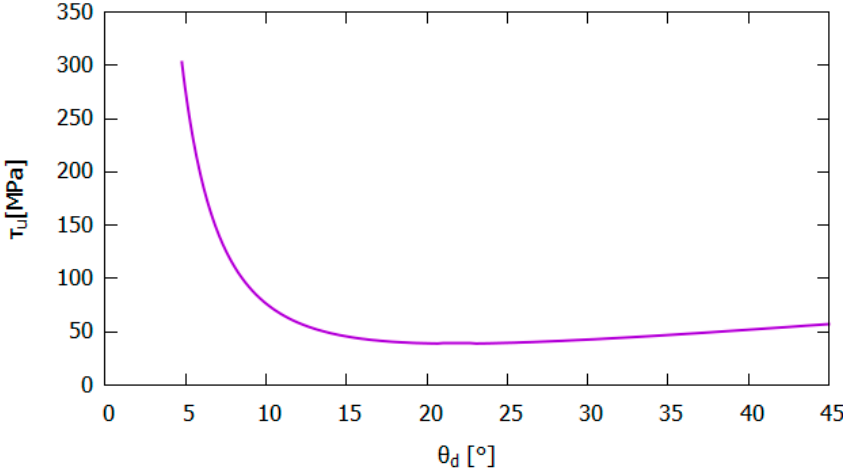
Figure 12. The variation of the ultimate shear stress with respect to the angle of the panel diagonal .